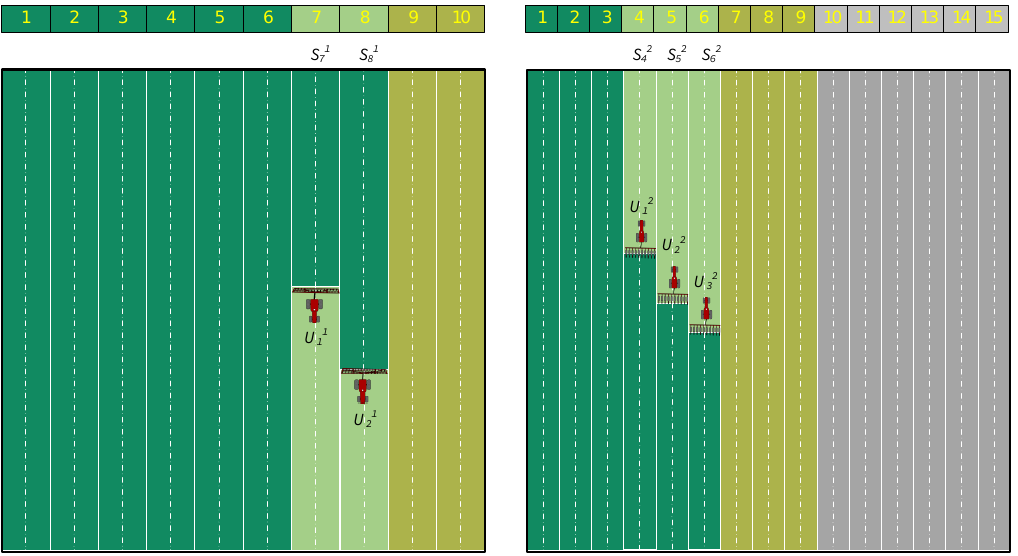
Figure 2. Expressions of operation tasks, operating strips, and machinery units. Table 1. Definitions of operating strip states.